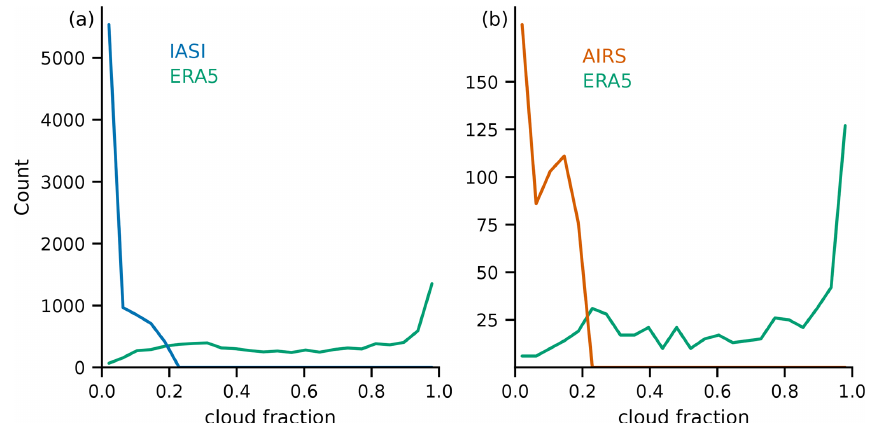
Figure 5. Cloud fraction distributions of the two collocation datasets (a) IASI/ERA5 and (b) AIRS/ERA5 after applying a cloud fraction threshold of 0.2 based on the IASI and AIRS cloud fraction